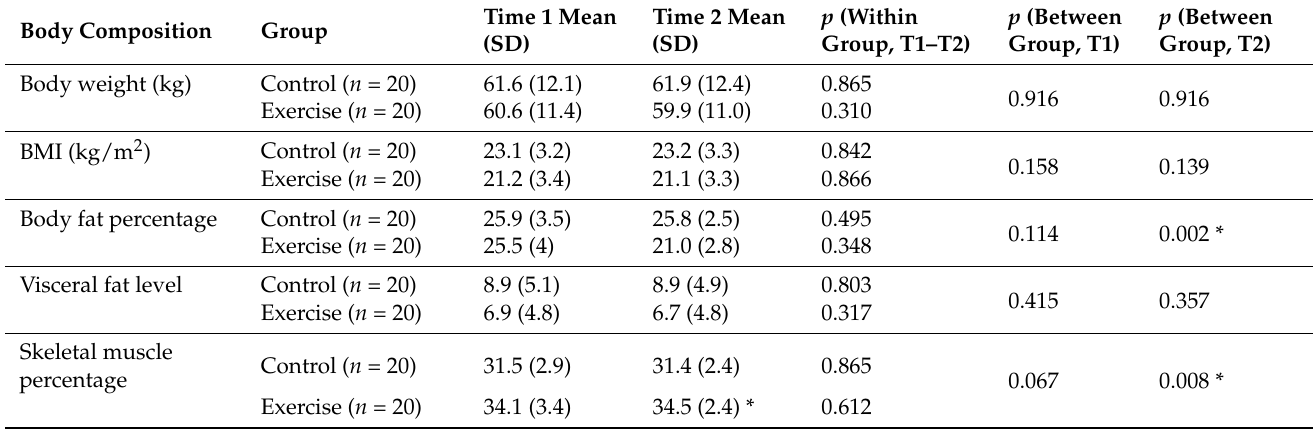
Table 2. Body composition between the exercise group and control group at pretest and